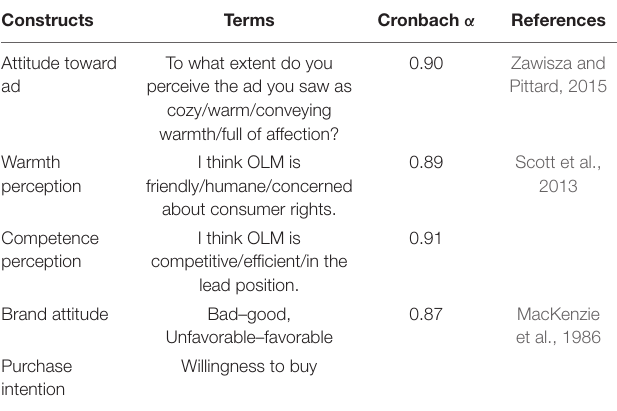
TABLE 1 | Relevant constructs and measures in Experiment